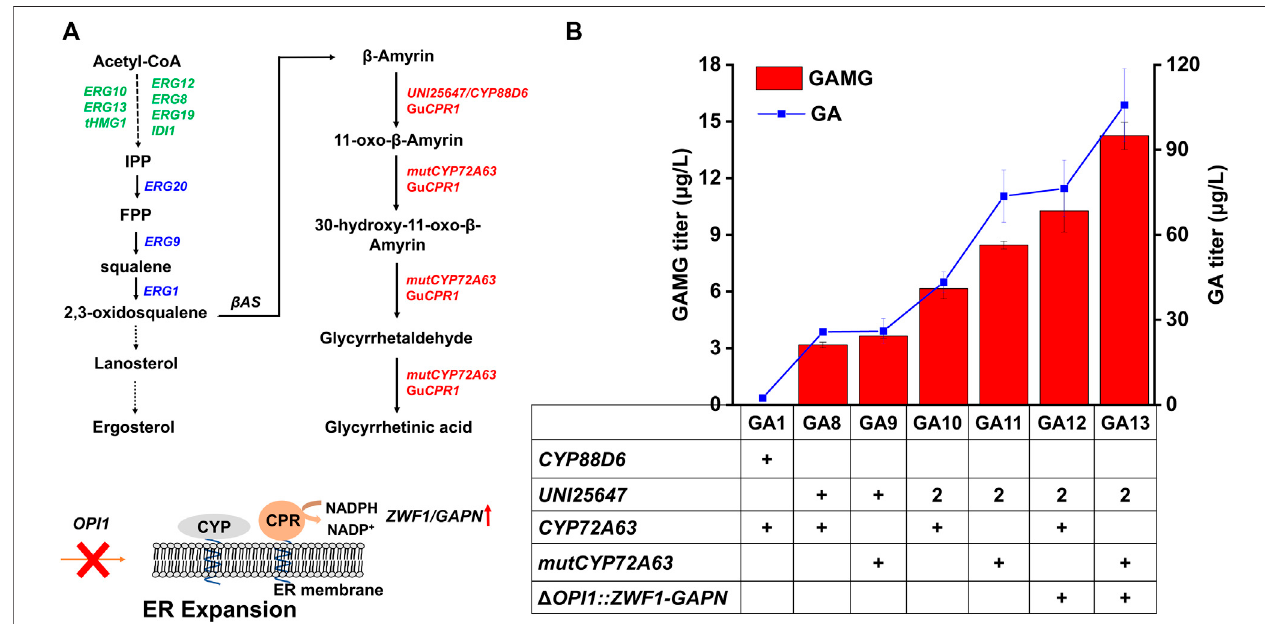
FIGURE2| OptimizationoftheGAmodule(moduleI)toimproveGAMGproduction. (A) OptimizationofGAbiosyntheticpathwayforimprovedGAMGproduction. Endogenousgenesoverexpressedin theparent strainBY4741-C-04 wereshown ingreen, endogenousgenesoverexpressedinthepresentstudy wereshowninblue, andheterologousgenesoverexpressedtosynthesizeGAwereshowninred. ZWF1 and GAPN wereoverexpressedtoenhanceNADPHsupplyand OPI1 wasdisrupted to provide more space for the folding of CYPs via ER membrane expansion. (B) Comparison of GA and GAMG production in engineered S. cerevisiae strains. ERG10: acetyl-CoA acetyltransferase; ERG13: hydroxymethylglytaryl-CoA synthase; tHMG1: truncated-3-methylglutaryl-CoA reductase; ERG12: mevalonate kinase; ERG8: phosphomevalonate knase; ERG19: diphosphomevalonate decarboxylase; IDI1: dimethylallyl diphosphate isomerase; ERG20: farnesyl pyrophosphate synthase; ERG9: squalene synthase; ERG1: squalene epoxidase; β AS: β -amyrin synthase; GuCPR1: cytochrome P450 reductase from Glycyrrhiza uralensis ; UNI25647: β -amyrin 11-oxidase; mutCYP72A63: the T388S/W205R mutant of 11-oxo- β -aymrin 30-oxidase; GAPN: NADP + -dependent